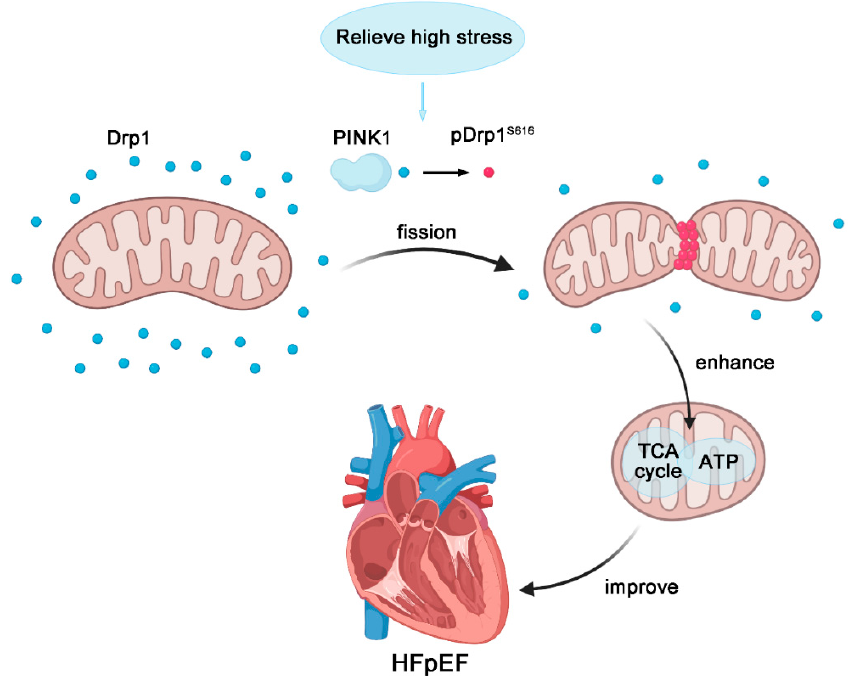
Figure 8. Molecular mechanism of PINK1-regulated hypertension-induced HFpEF. PINK1 increases phosphorylation level of Drp1 S616 and mitochondrial localization of Drp1 to stimulate mitochondrial fission, thereby restoring mitochondrial function and ultimately slowing the development of hyper- tension-induced HFpEF.